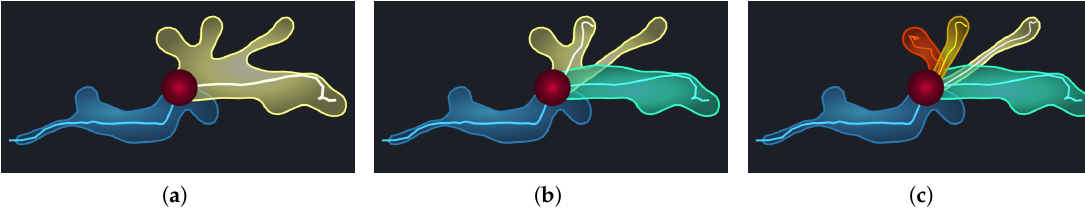
Figure 7. Shuttlecock for ensemble pathline: ( a ) displaying the clustered pathline members with Eps = 0.8 and MinPts = 1; ( b ) displaying the clustered pathline members with Eps = 0.75 and MinPts = 1; and ( c ) displaying the clustered pathline members with Eps = 0.75 and MinPts = 2;